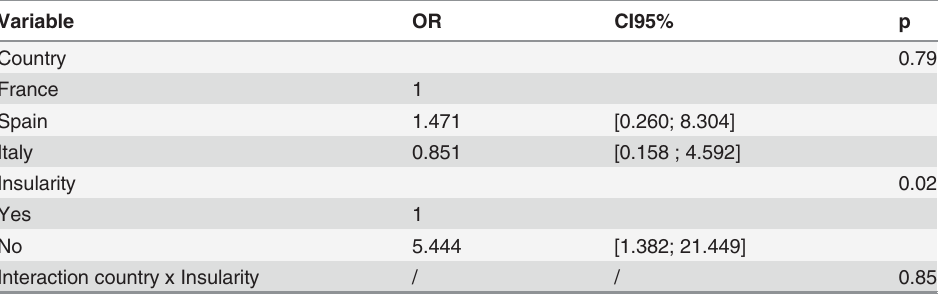
Most of the combined sequences corresponded to specific geographical areas (Tables 1; Fig. 2). Three combined Pneumocystis sequence types were detected in the woodmice from the Pyre- nees (France). Similarly, unique Pneumocystis sequence types were characterized in the Table 2. Pneumocystis carriage in woodmouse: influence of the country of origin and insularity ver- sus mainland (multivariate analysis) a